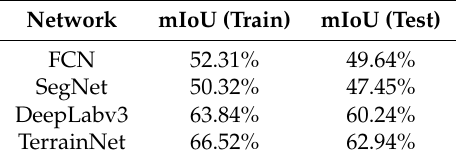
Table 10. Comparative experiments with other networks on